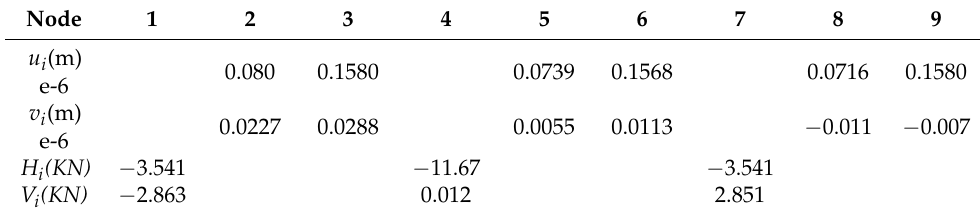
Table 4. Deflections and reactions at the example from the direct